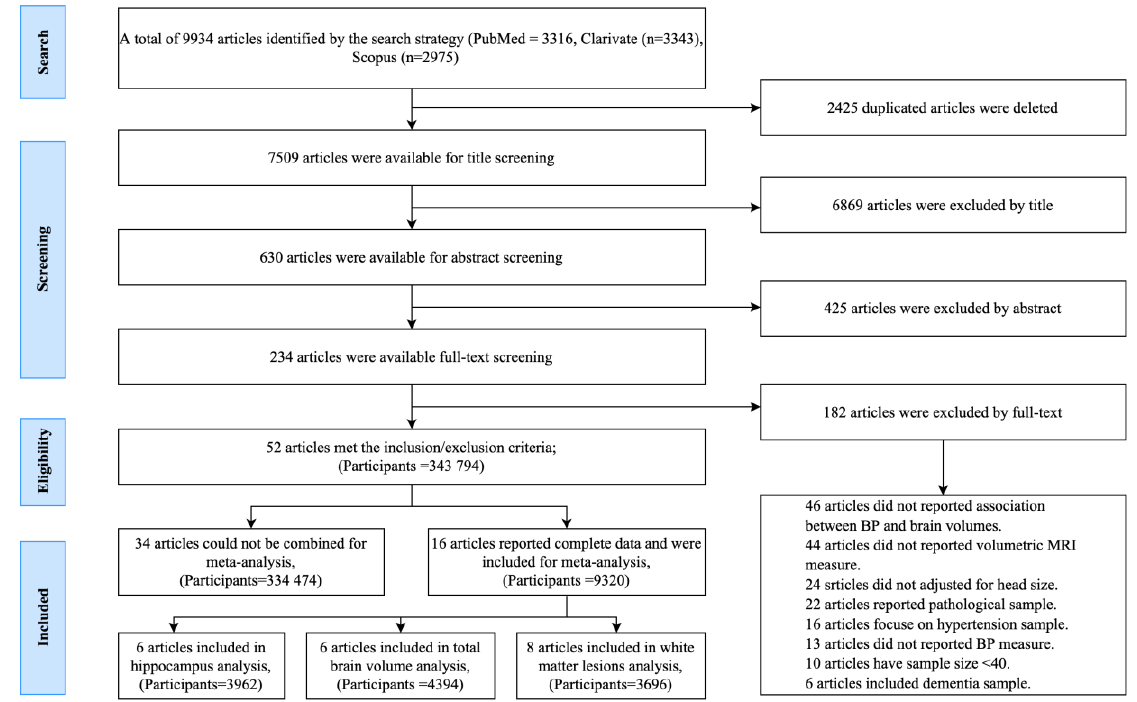
Figure 1. PRISMA flow diagram presenting the number of studies excluded and included at every stage of the review process, and the final number of studies included in the systematic review and meta-analysis.